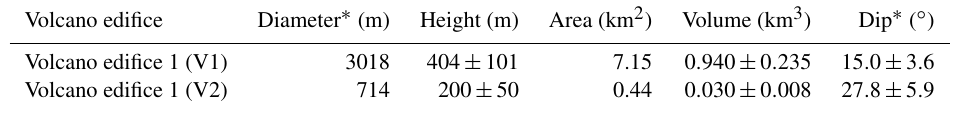
Table 1. Dimensions of volcano edifices. Volcano edifice Diameter ∗ (m) Height (m)